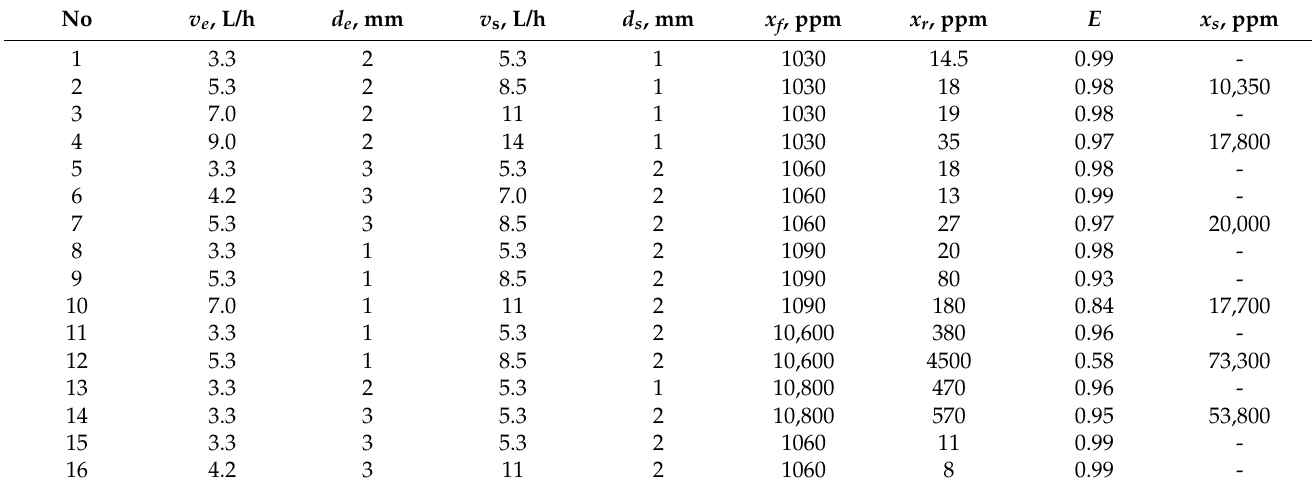
Table 3. Conditions and results of experiments conducted in the large